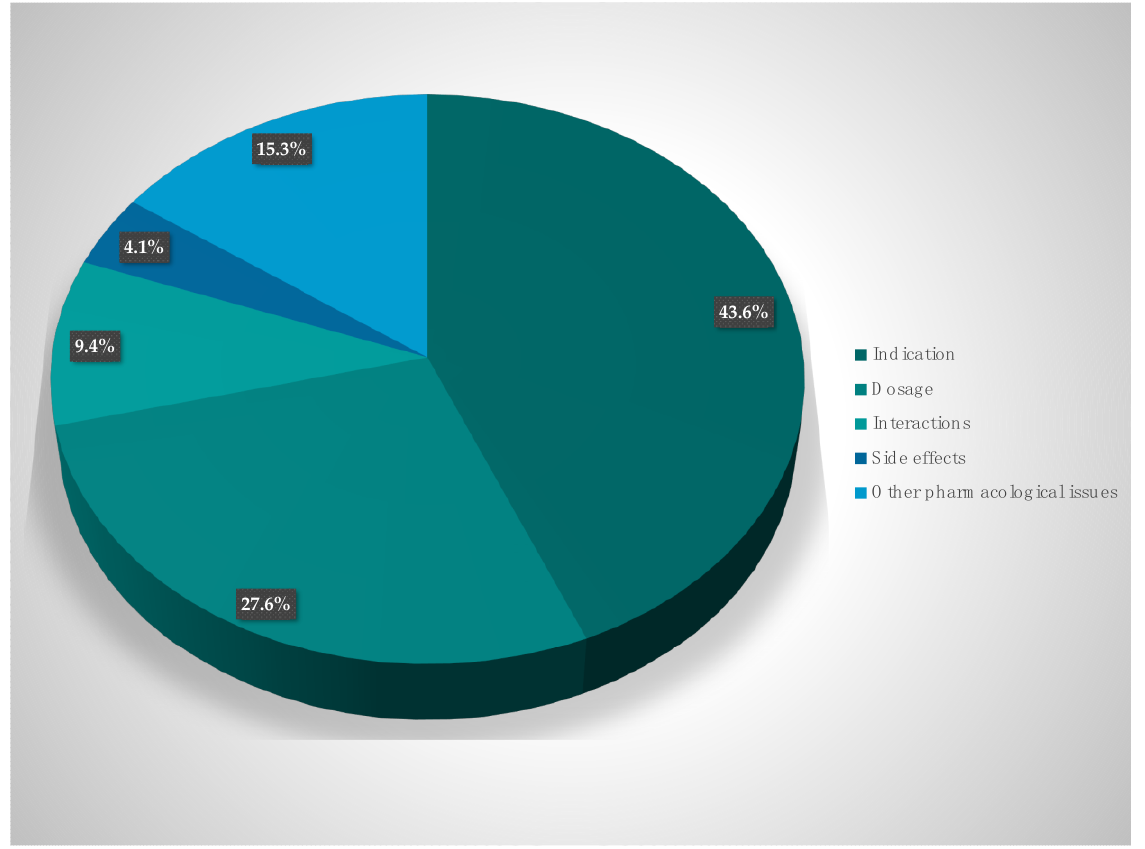
Figure 1. Intervention proposals (%).